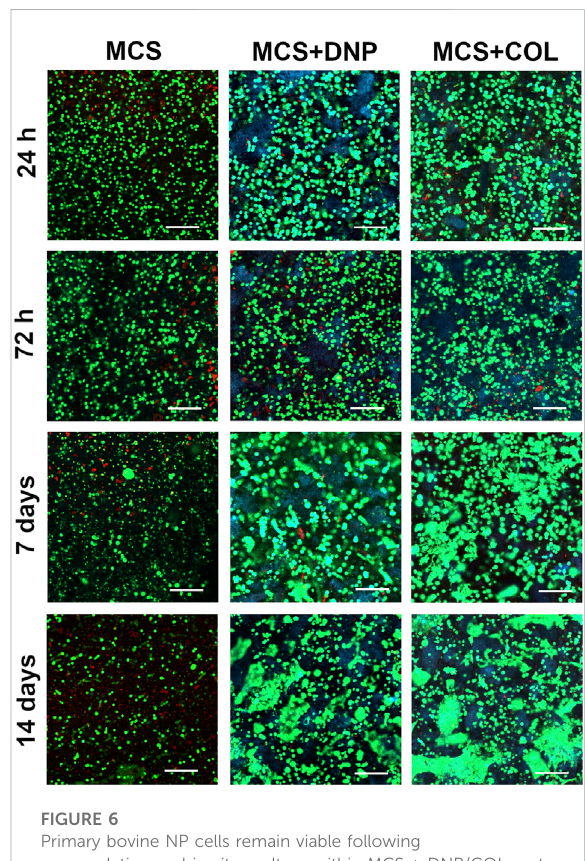
FIGURE 6 Primary bovine NP cells remain viable following encapsulation and in vitro culture within MCS ± DNP/COL up to 14 days. Unpassaged P0 primary bovine NP cells were encapsulated within MCS, MCS + DNP or MCS + COL hydrogels, and cultured in vitro for 24 h, 72 h, 7 days, or 14 days. Representative confocal microscopy images were captured at eachtimepointshowinglivecellsstainedwithcalcein-AM (green), dead cells with ethidium homodimer-1 (red), and auto- fl uorescence of DNP and COL particles (blue). Images were captured at depths between 75 – 150 μ m from the surface of each hydrogel construct. Scale bars = 200 μ m. Images are representative of N = 3 individual cell